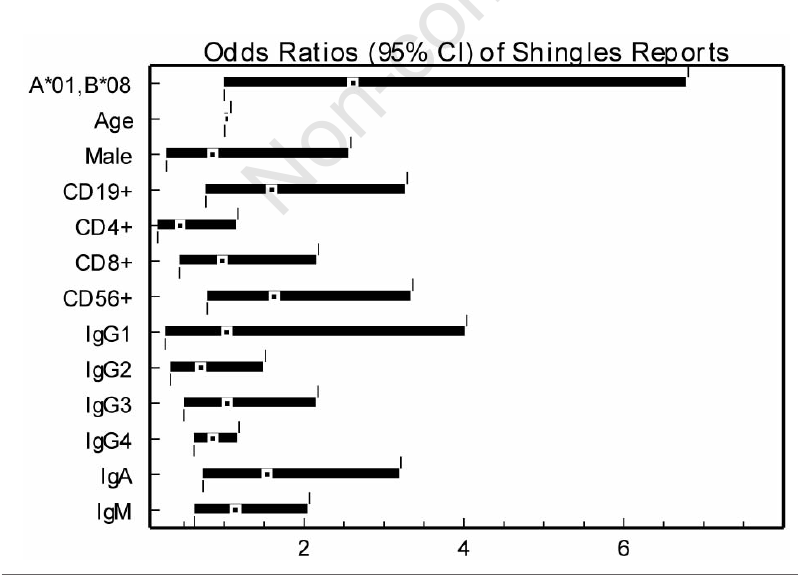
Figure 2. Odds ratios for reports of shingles at diagnosis in 212 Alabama index patients at diagnosis of common variable immunodeficiency or immunoglobulin G subclass defi- ciency (CVID/IgGSD). A*01, B*08 represents positivity for human leukocyte antigen haplotype A*01, B*08. CD entries denote subpopulations of blood mononuclear cells. Ig entries denote serum levels of